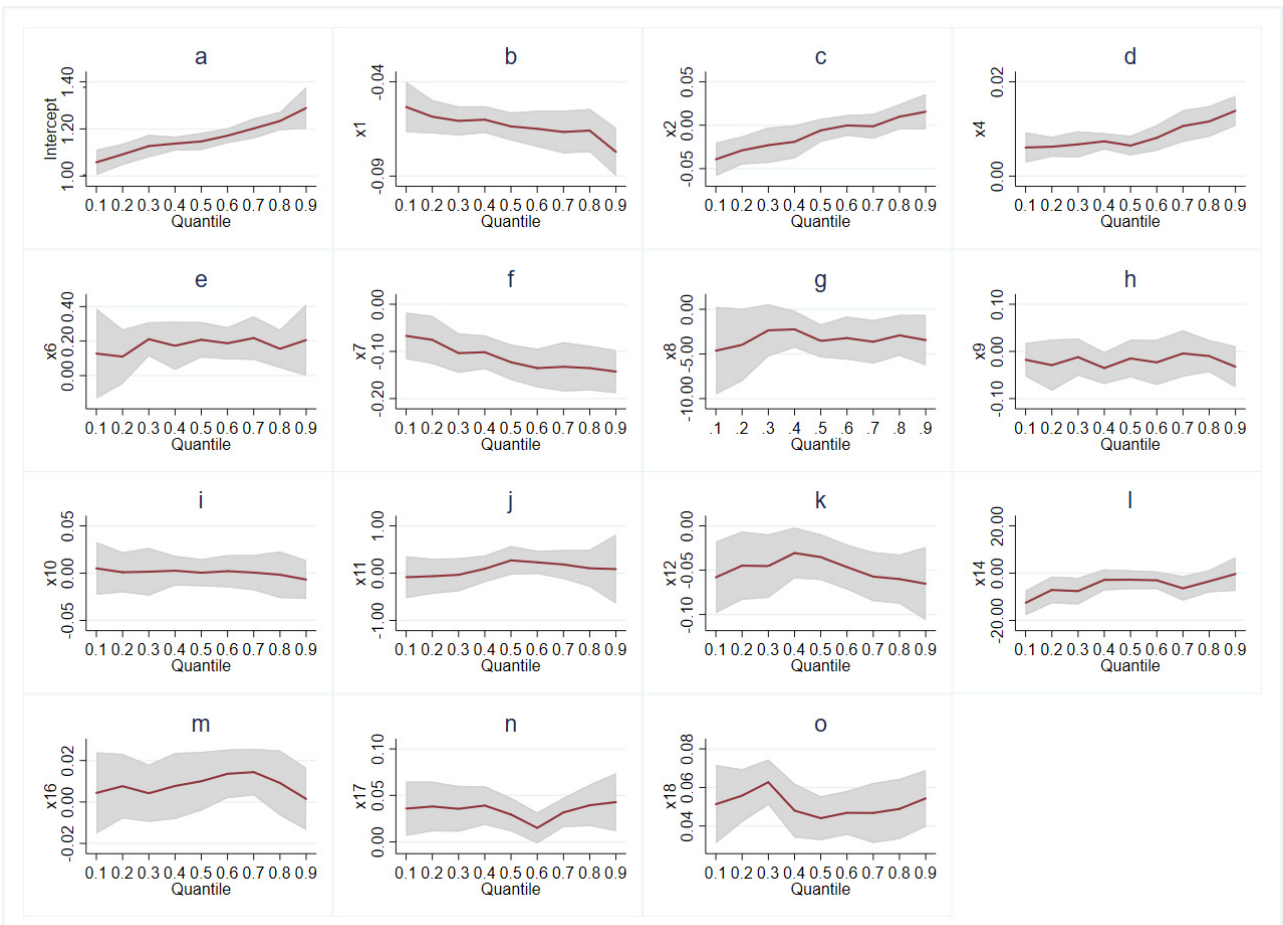
Figure 3. Graphics of quantile regression coefficient between total BMD with different variables. ( a ) intercept of regression; ( b ) gender; ( c ) age; ( d ) race; ( e ) HDL; ( f ) TC; ( g ) lead; ( h ) cadmium; ( i ) total mercury; ( j ) selenium; ( k ) manganese; ( l ) ethyl mercury; ( m ) smoking/cigarette use; ( n ) alcohol use; ( o ) BMI.